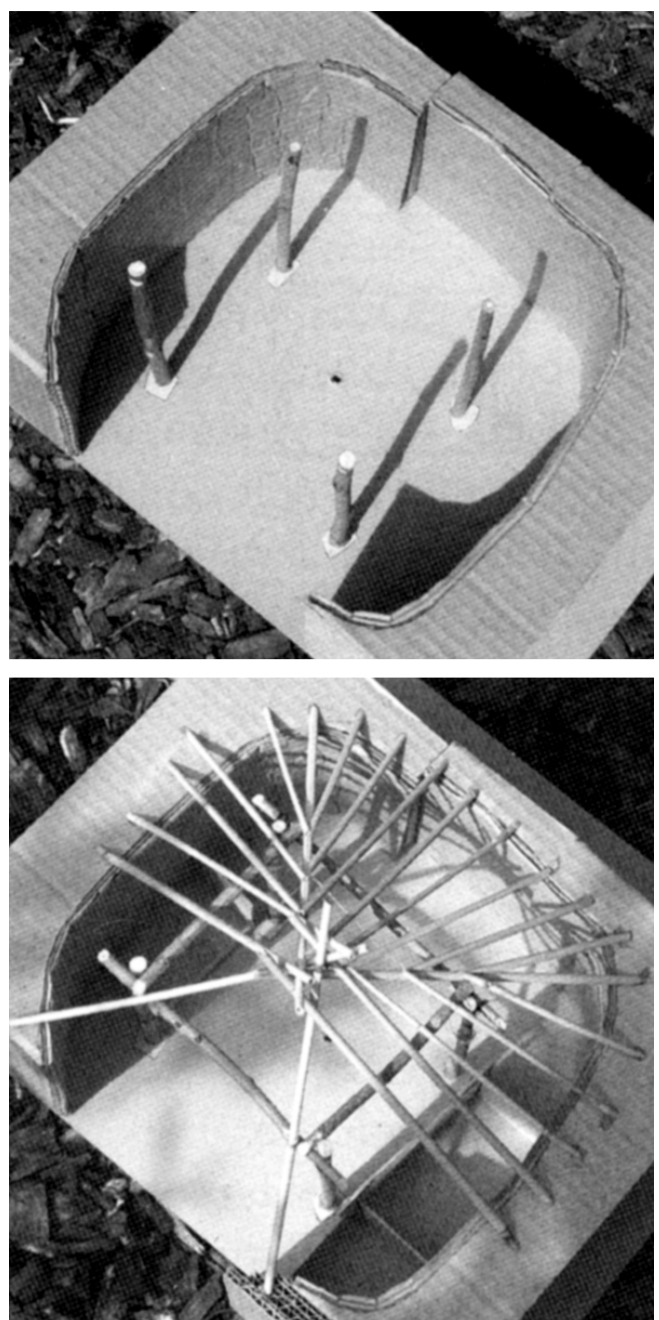
Figure 8. Architectural sketch models of a Neolithic dwelling at Skara Brae, Trevor Garnham and Harry Paticas [42]. Photo: courtesy Trevor